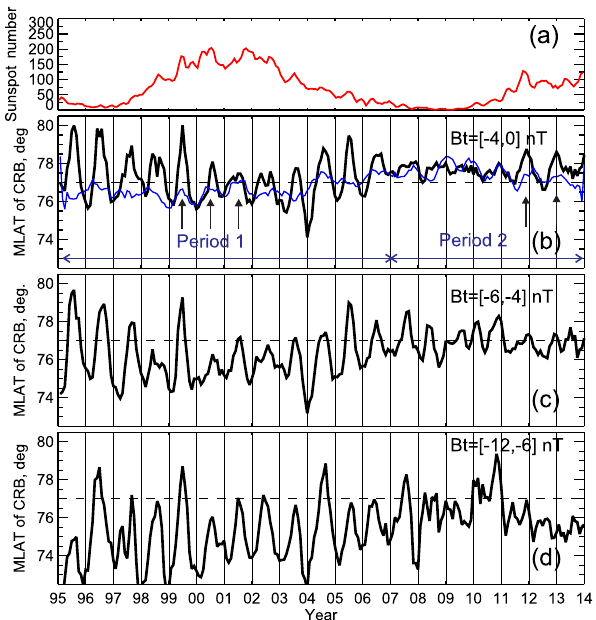
Figure 4. (a) Plot of the Sunspot Number for the period of 1995– 2013 (monthly average number, http://sidc.oma.be/silso). Magnetic latitude of the convection reversal boundary location, black line, at dusk (between 17:00 and 19:00MLT) for SuperDARN observa- tions between 1995 and 2013 for B z < 0 and (b) B − t = [ − 4,0]nT, (c) B − t = [ − 6, − 4]nT and (d) B − t = [ − 12, − 6]nT, respectively. Panel (b) also shows magnetic latitude of the convection rever- sal boundary location, blue line, at dawn (between 05:00 and 07:00MLT). In this panel, arrows indicate some years for which poleward shift of the convection reversal boundary occurs both at dusk and dawn.